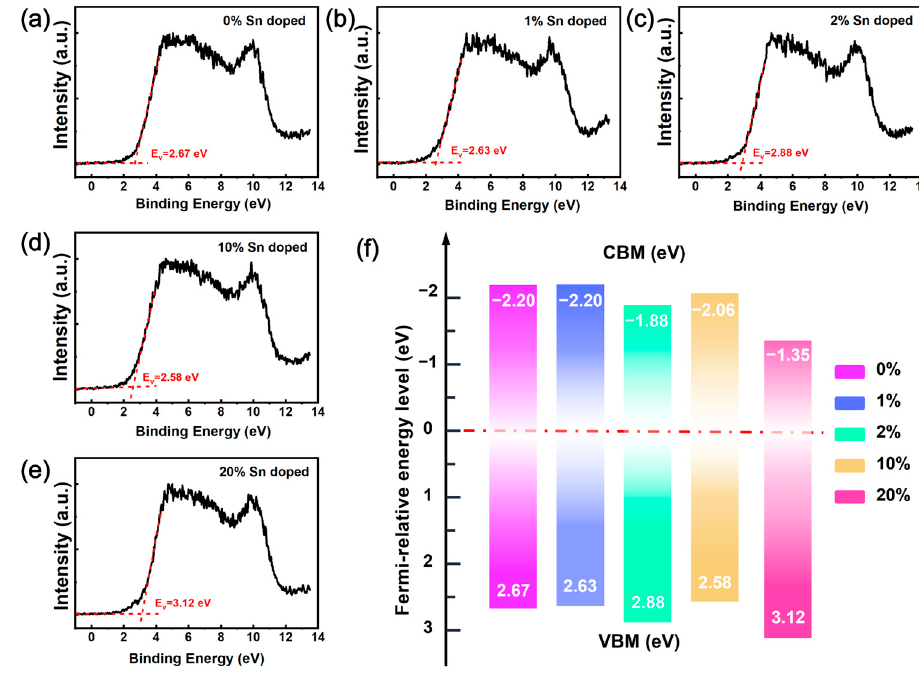
Figure 5. ( a – e ) XPS valence-band spectra and VBM of the annealed Ga 2 O 3 thin films with varying Sn content. ( f ) VBM and CBM energy alignments for the Ga 2 O 3 thin films as a function of Sn con- centration.